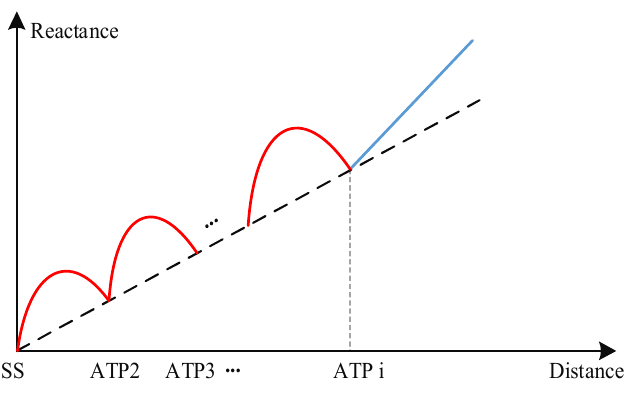
Figure 5. Measured reactance with fault distance.